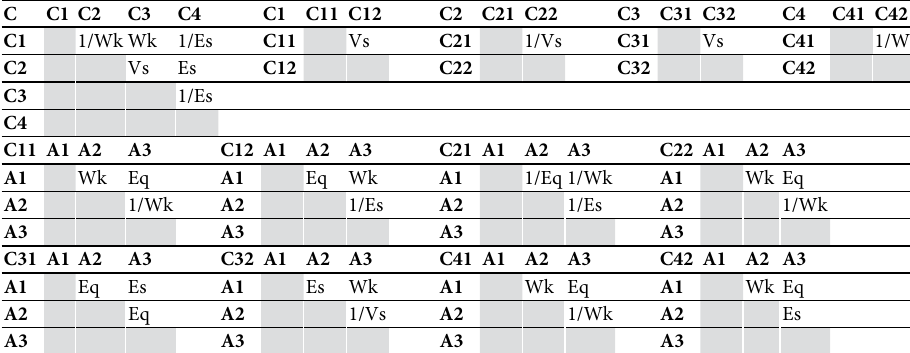
Table A1. Pairwise matrices of Expert 1